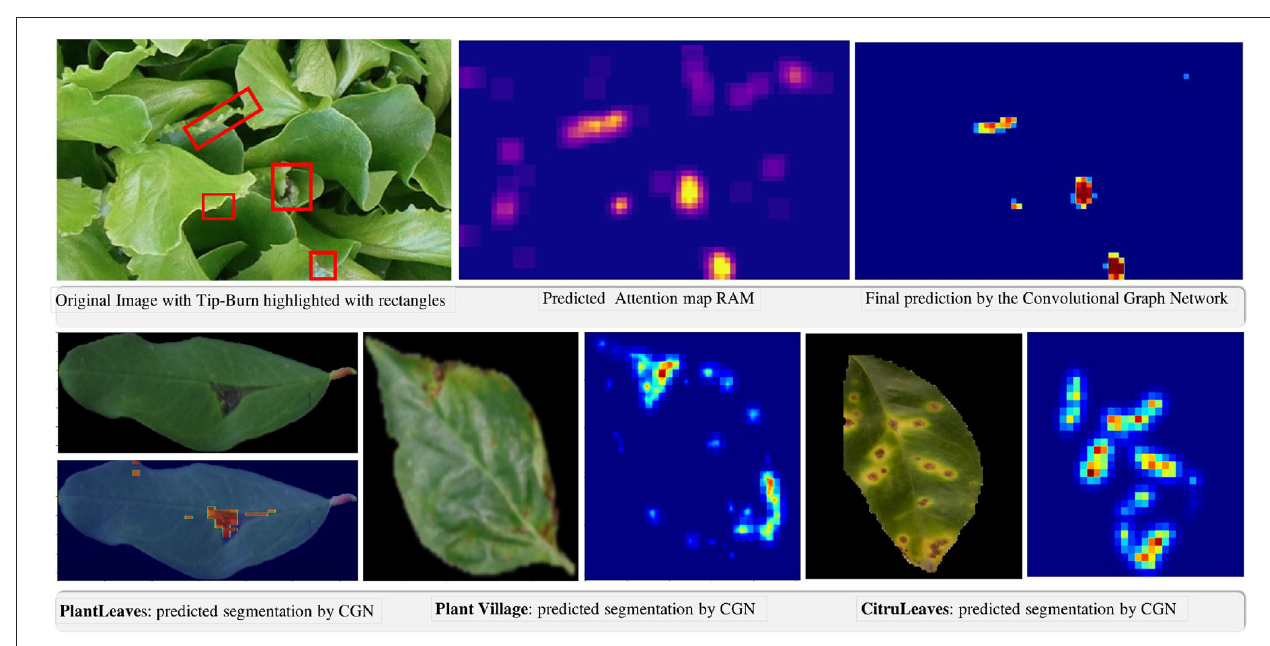
FIGURE 9 | Qualitative results of the weakly supervised semantic segmentation of tip-burn stress and of disease spot and lesions on PlantVillage, PlantLeaves, and CitrusLeaves.